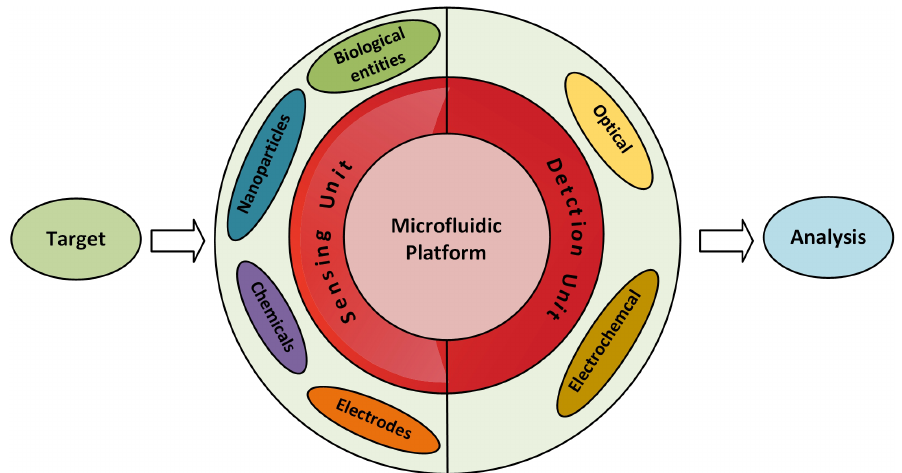
Figure 1. Illustration of a microfluidic sensing